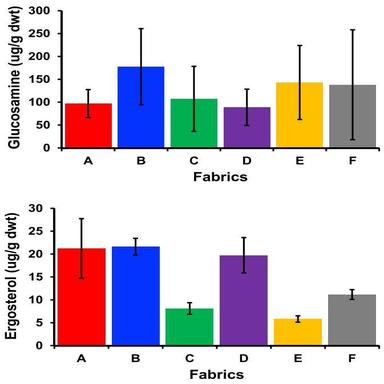
The quantity (μg/g dry weight) of glucosamine (top) and ergosterol (bottom) across six fabric samples exposed to harsh environmental condition for 14 months.